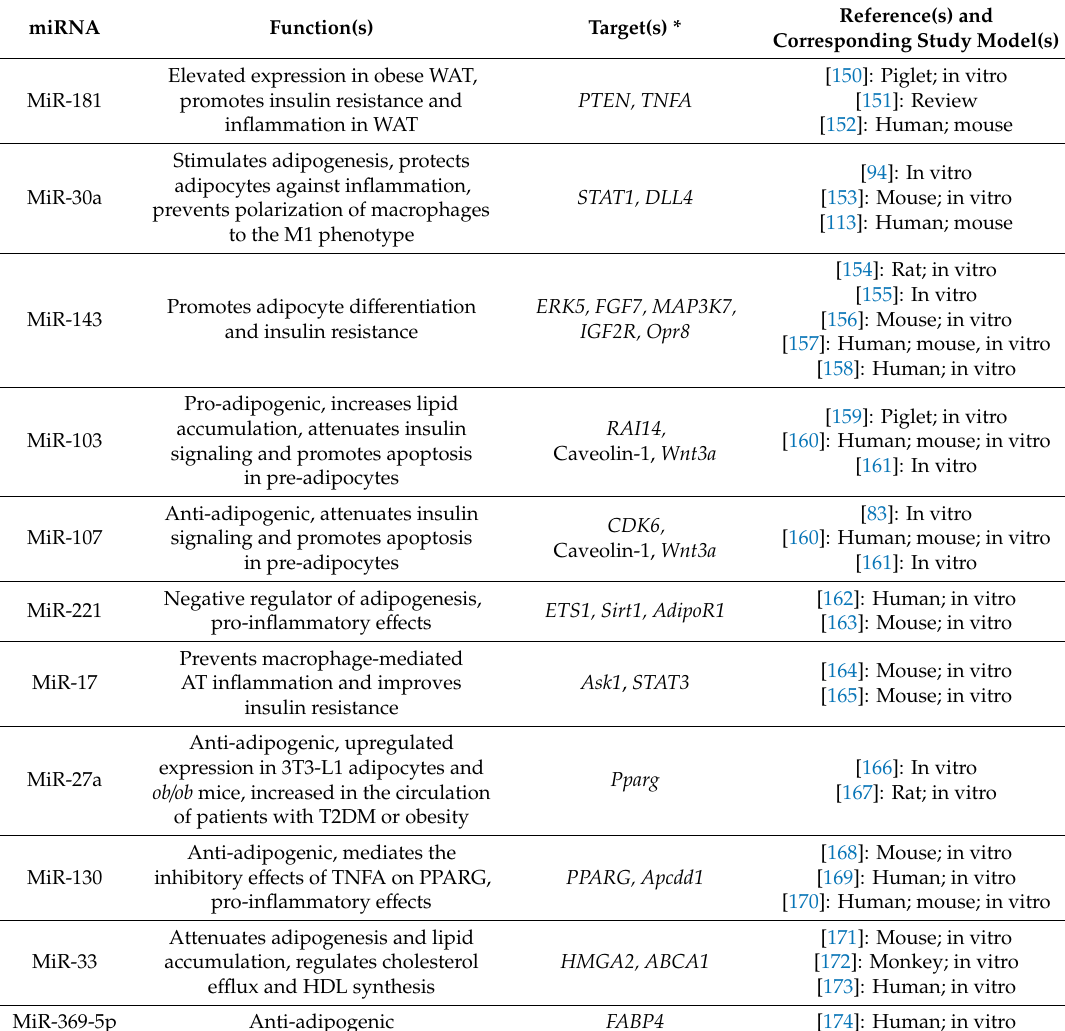
Table 3. Selected key microRNAs (miRNAs) and their reported e ff ects in white adipose tissue